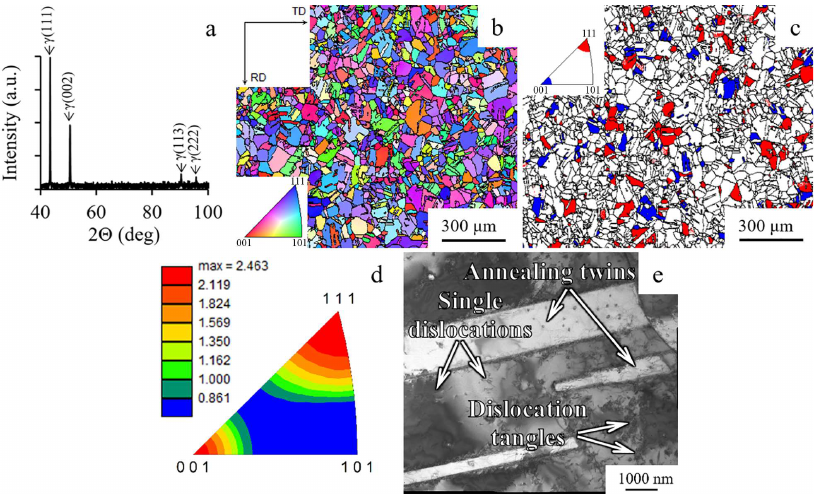
Figure 1. ( a ) XRD pattern, ( b ) inverse pole figure map, ( c ) texture map, ( d ) inverse pole figure, and ( e ) TEM-structure of the as-received program steel.